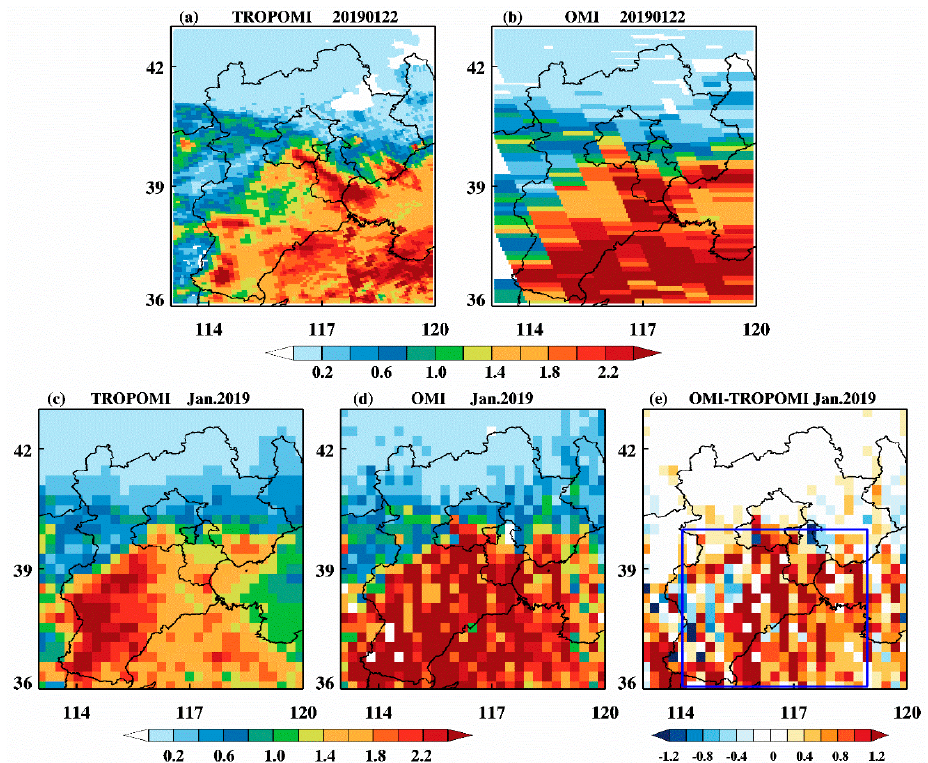
Figure 5. ( a , b ) Tropospheric NO 2 measured by TROPOMI75 and OMI on 22 January 2019 over the Jing-Jin-Ji region. ( c , d ) The same as ( a , b ) but for the average of January 2019. ( e ) The absolute difference of OMI minus TROPOMI tropospheric NO 2 columns averaged in January 2019. Blue box denotes the area with high NO 2 loadings. (units: 10 16 molec cm –2 ).